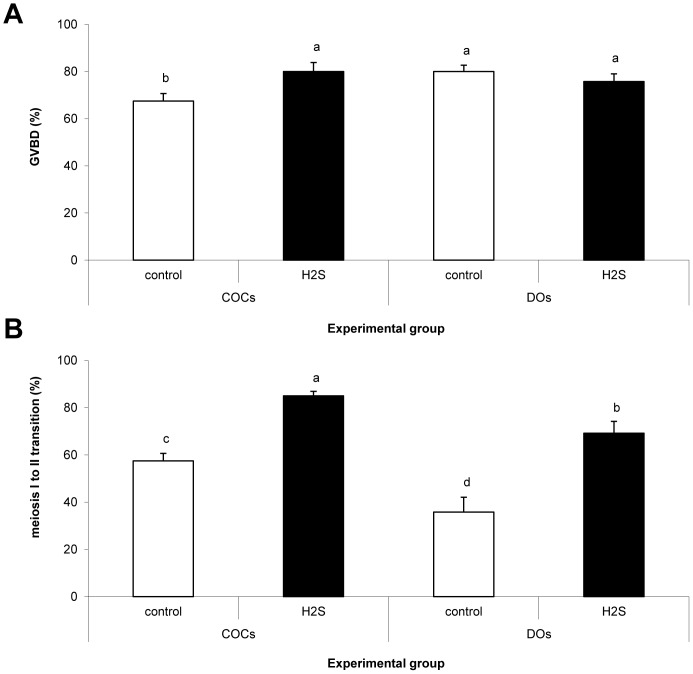
Effect of Na2S on meiosis resumption and transition to meiosis II in DOs.Proportion of GVBD (A) and meiosis I to II transition (B) during in vitro cultivation after 20 and 30 h in vitro cultivation, respectively. H2S: 300 µM Na2S. a,b,cStatistically significant differences among experimental groups (P<0.05).